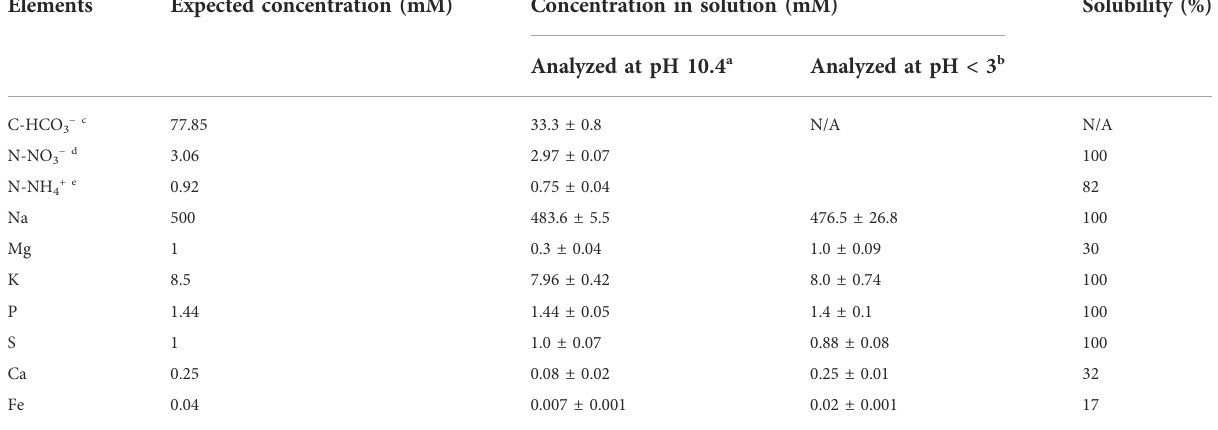
TABLE 1 Concentration (mM) of nutrients at high pH (10.4), reduced pH ( < 3), and solubility